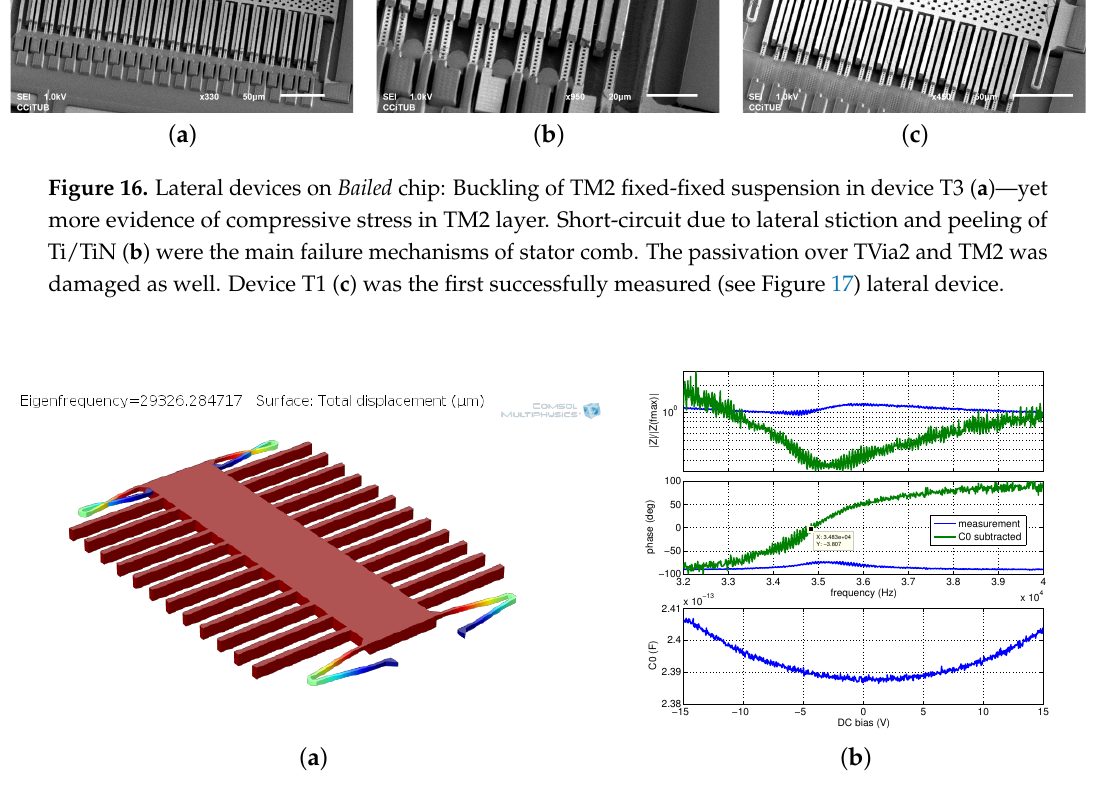
Figure 17. Device T1: modal simulation indicating eigenfrequency at 29.3 kHz ( a ); and impedance measurements with resonance at 34.8 kHz ( b